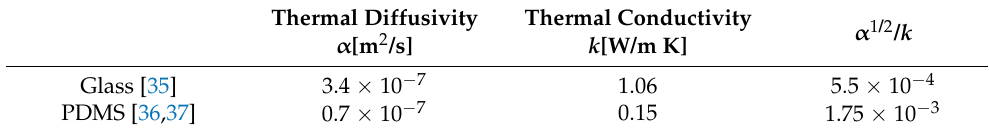
Table 1. Thermal properties of glass and